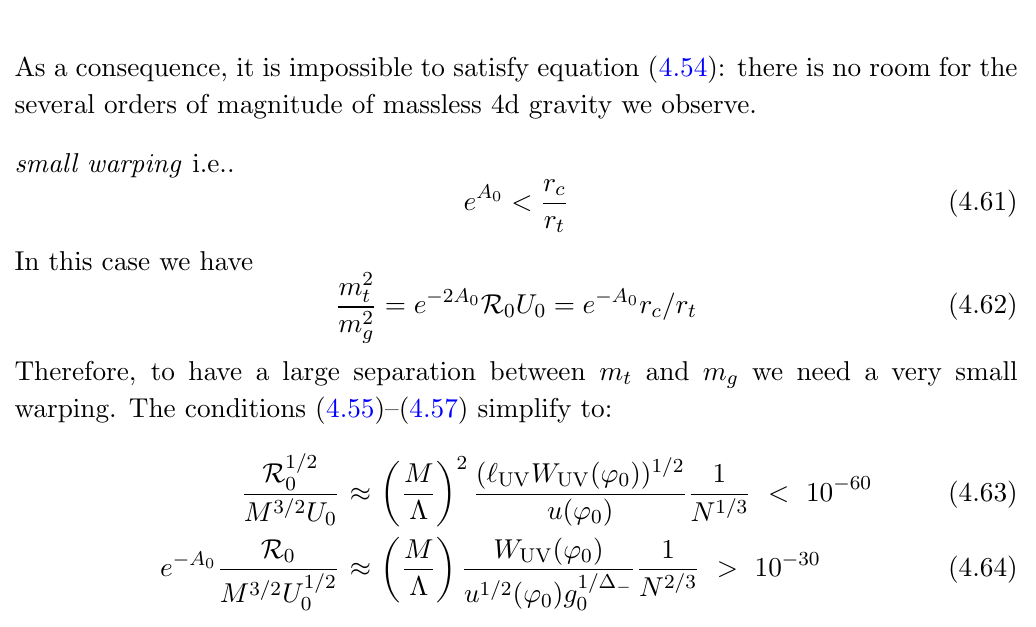
Figure 14 . The horizontal direction represents the hierarchy of distance scales in the \massive gravity 2" scenario. Similarly to the \massive gravity 1" scenario ((cid:12)gure 13), at distances larger than 1 =m g we have a transition to massive gravity. However there is no short-distance modi(cid:12)cation until below the cut-o(cid:11) scale r UV